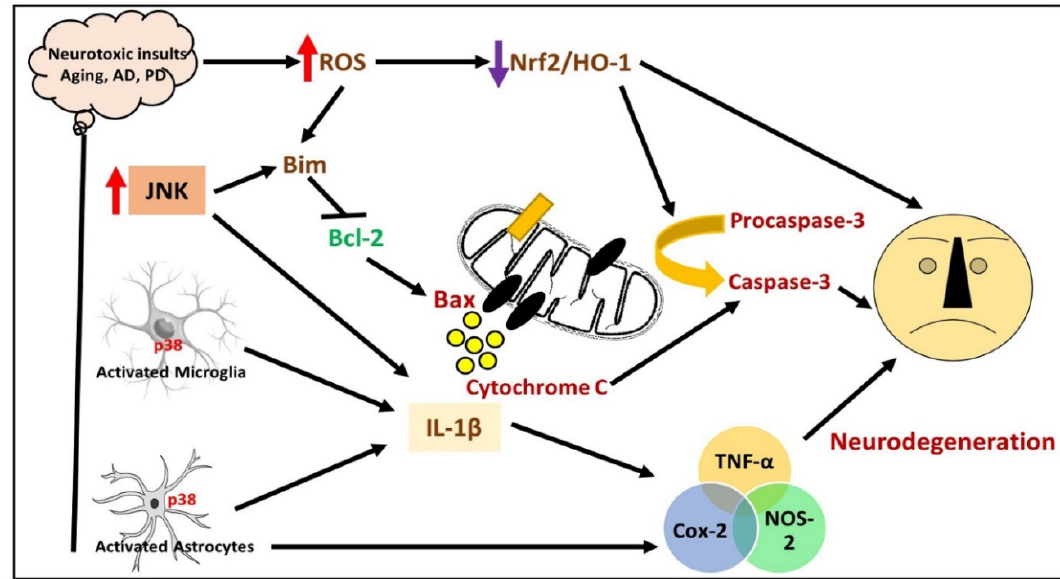
Figure 1. Neuronal cell loss in neurodegenerative conditions. Neurodegeneration can be induced by several stimuli; the activation of microglia and astrocytes results in the release of inflammatory mediator progression of apoptotic degeneration. Elevation in oxidative stress and the downregulation of Nrf2/HO-1 may also contribute to the process of aging. IL-1 β : Interleukin-1, AD: Alzheimer’s disease, PD: Parkinson’s disease, ROS: Reactive oxygen species, Nrf2: Nuclear factor-2 related factor-2, HO-1, Heme oxygenase-1. TNF- α : Tissue necrosis factor-alpha, Cox-2: Cyclo-oxygenase-2, NOS-2: Nitric oxide synthase-2.